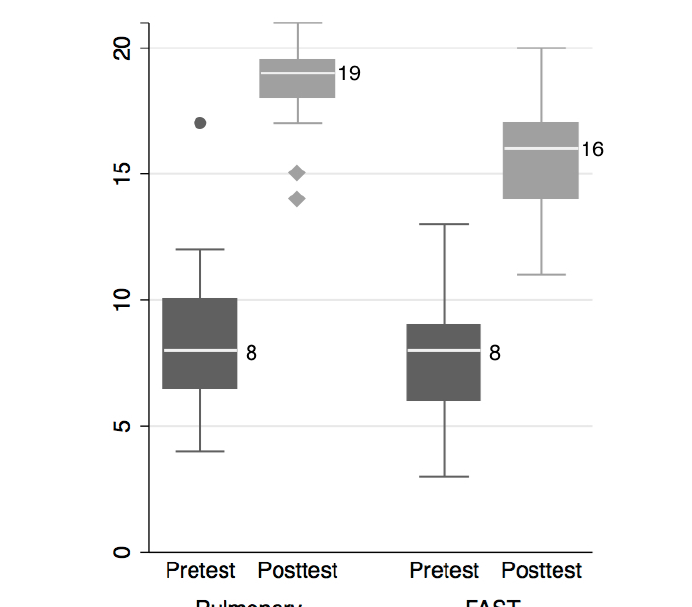
Figure 1. Boxplot of written Clinical Knowledge pre- and post-Ultrafest scores for Pulmonary Exam and FAST (Focused Assessment of Sonography for Trauma) n